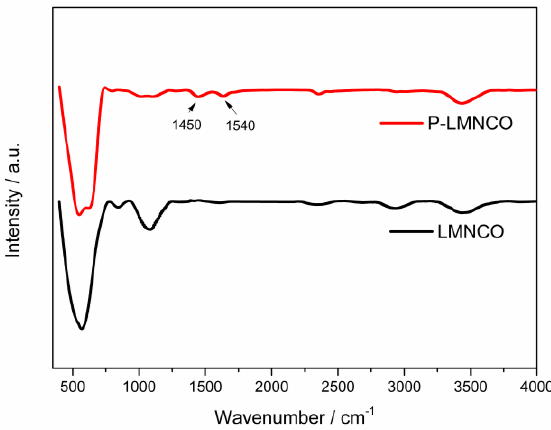
Figure 3. The FTIR spectra of LMNCO and P-LMNCO.